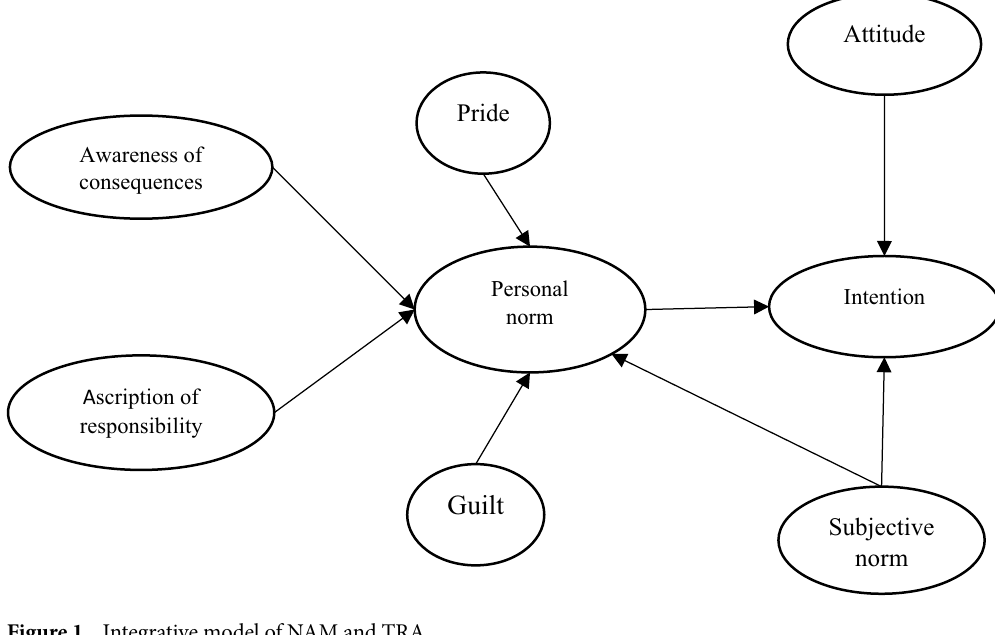
Figure 1. Integrative model of NAM and